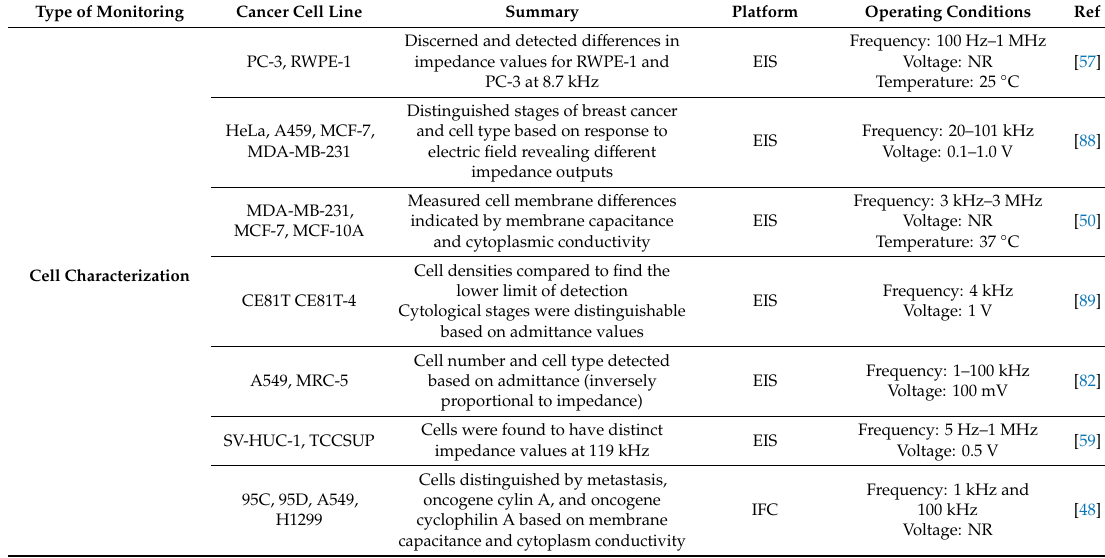
Table 1. Summary of impedance spectroscopy for cancer cell